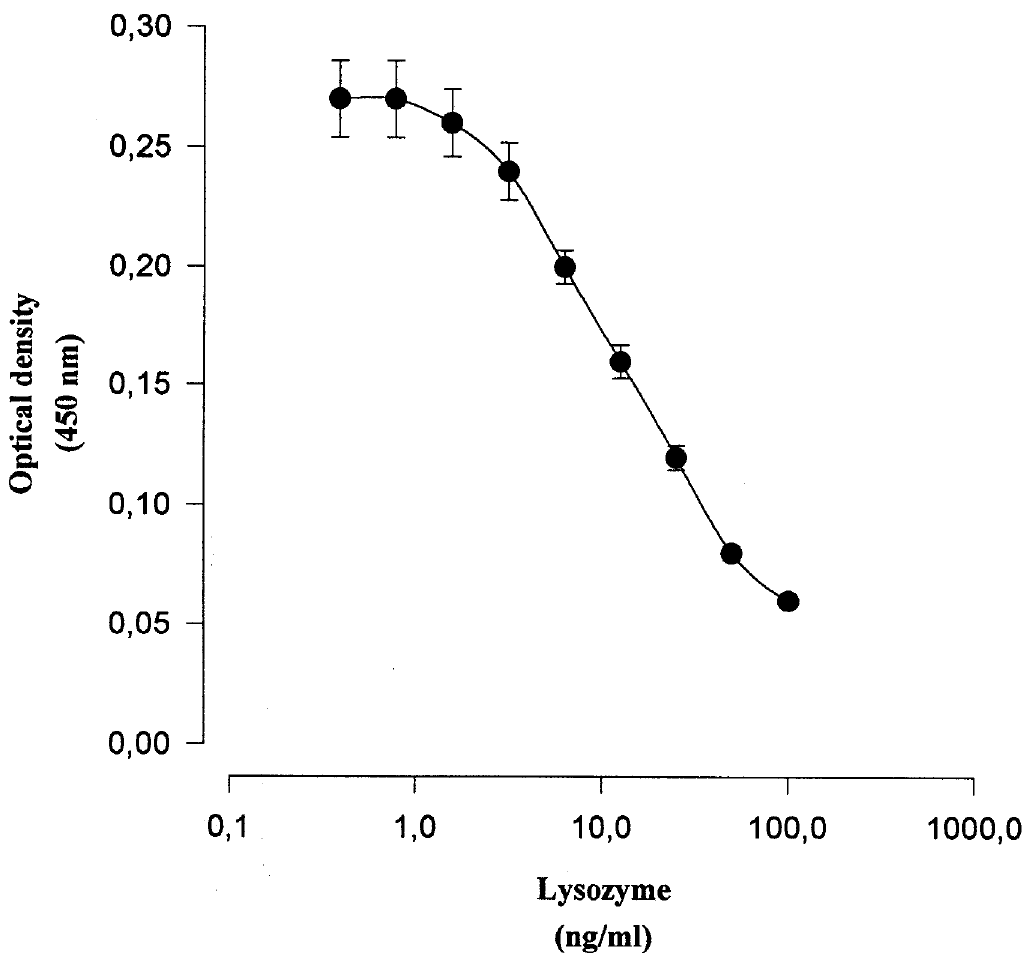
FIG. 1. Calibration curve of the rate-of-lysis assay based on the bactericidal activity of lysozyme. Data points represent the means±SEM ( n =15) for optical density measured in triplicate at 450nm at each egg-white standard concentration (0.5–100ng/